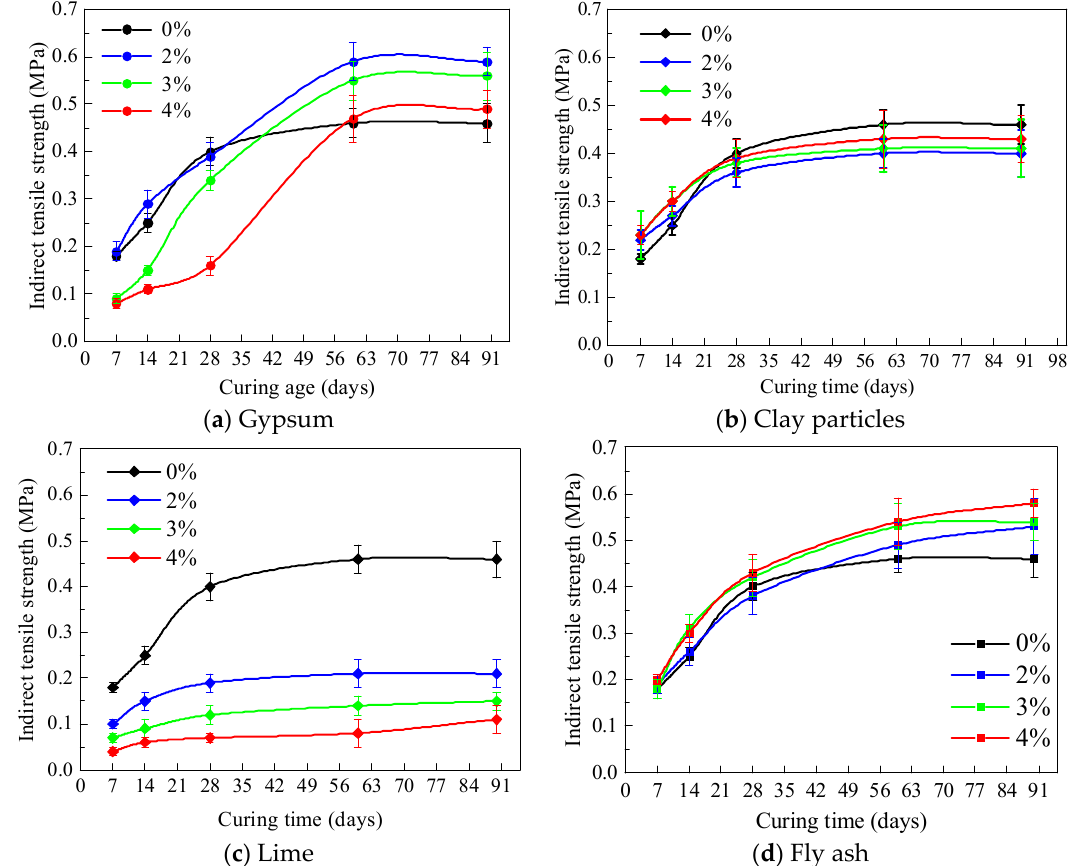
Figure 6. Curve of indirect tensile strength with different replacement ratios of the additives. Table 5. Test results for indirect tensile strength